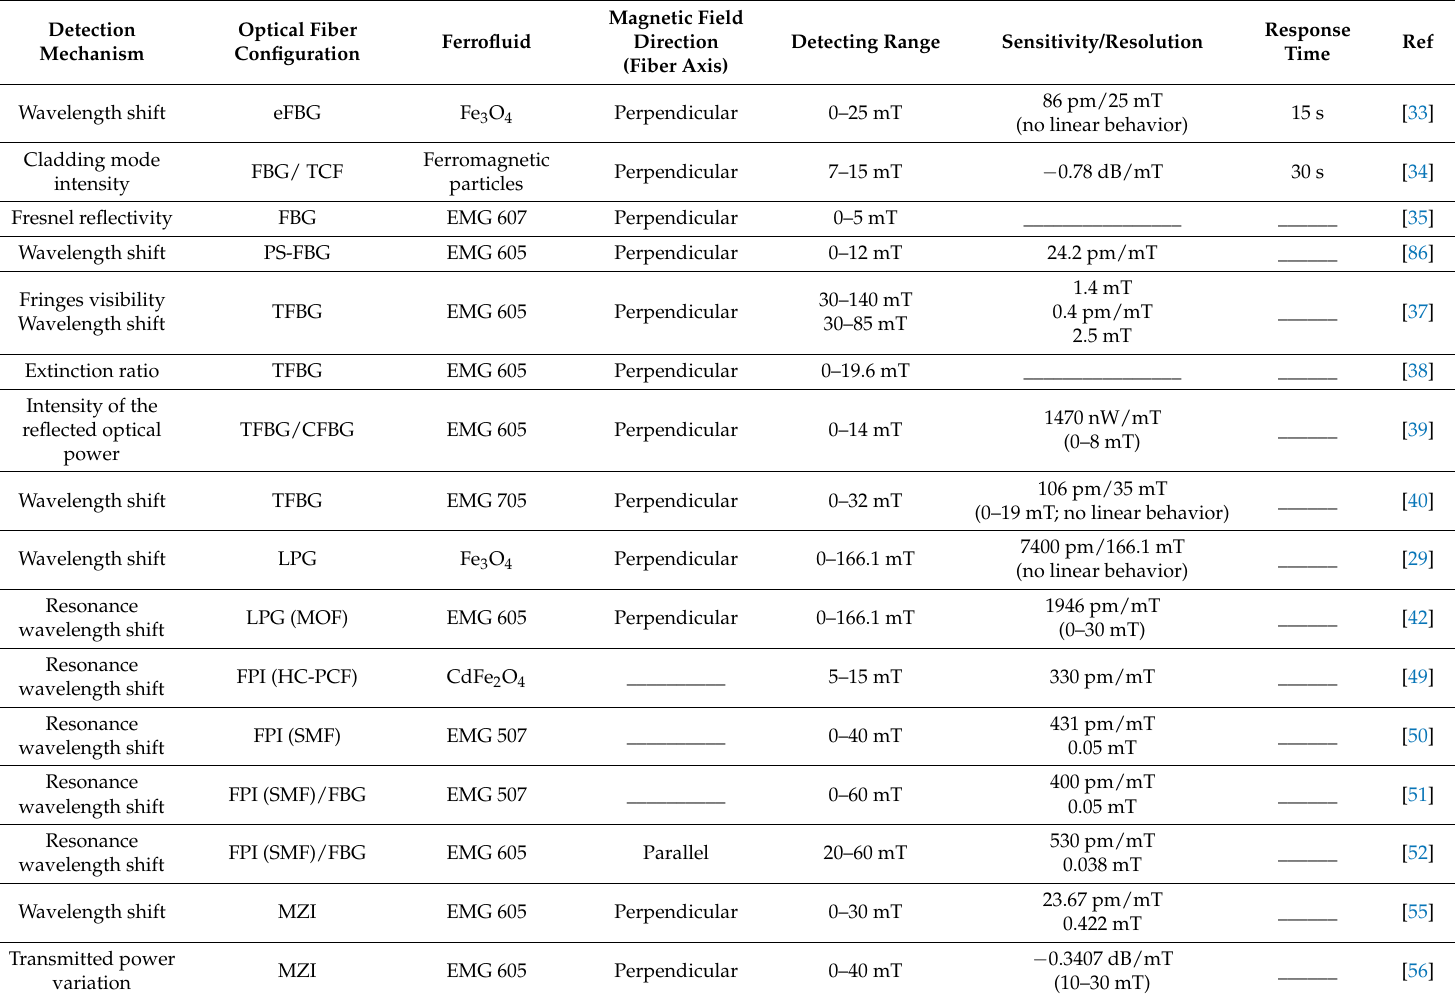
Table 2. Performance parameters of optical fiber magnetic field sensors based on